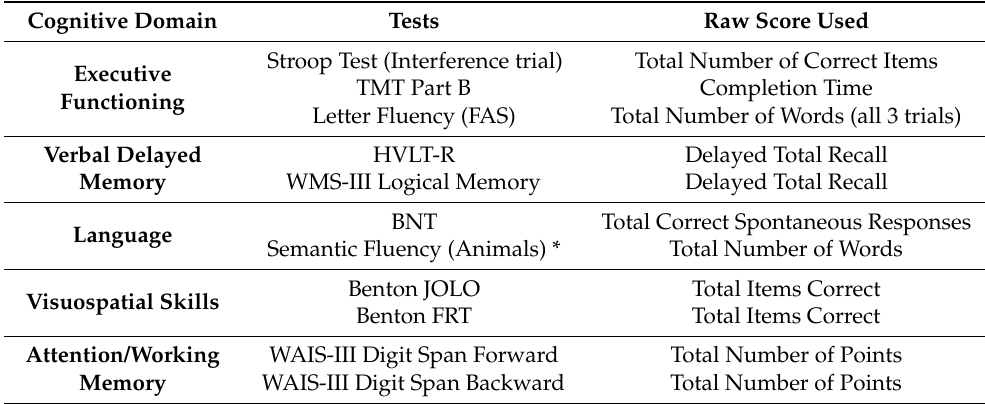
Table 1. Neuropsychological Tests within Each Cognitive Domain